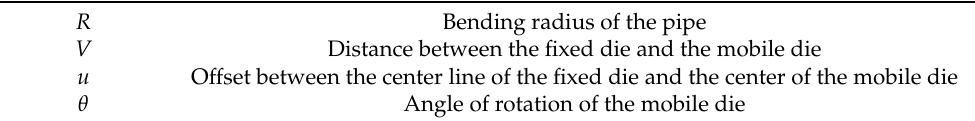
Figure 1. Principle of spatial variable curvature bending forming. Table 1. Bending parameters of pipe.